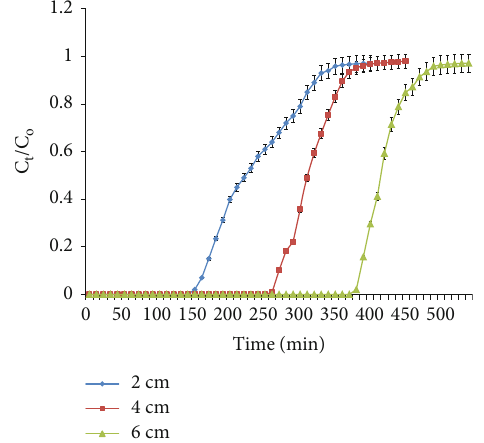
Figure 3: E ff ect of bed height on breakthrough curves obtained for the removal of Pb 2+ by ZSM-5/AC ( fl ow rate 2mL min -1 , initial metal concentration 250 mgL -1 , pH 6, 303 ° C, and error bars represent the standard deviation at n = 3 ).